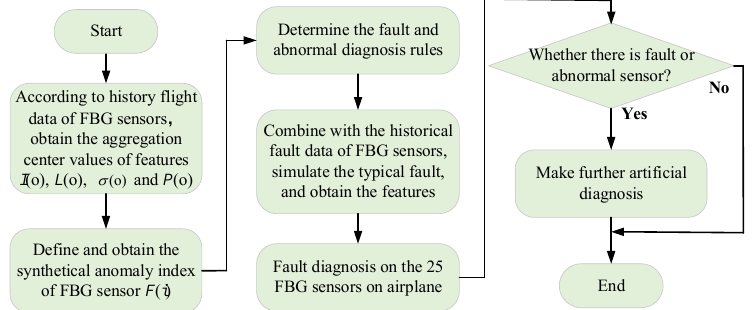
Figure 6. Fault detection process of FBG sensors on the airplane.